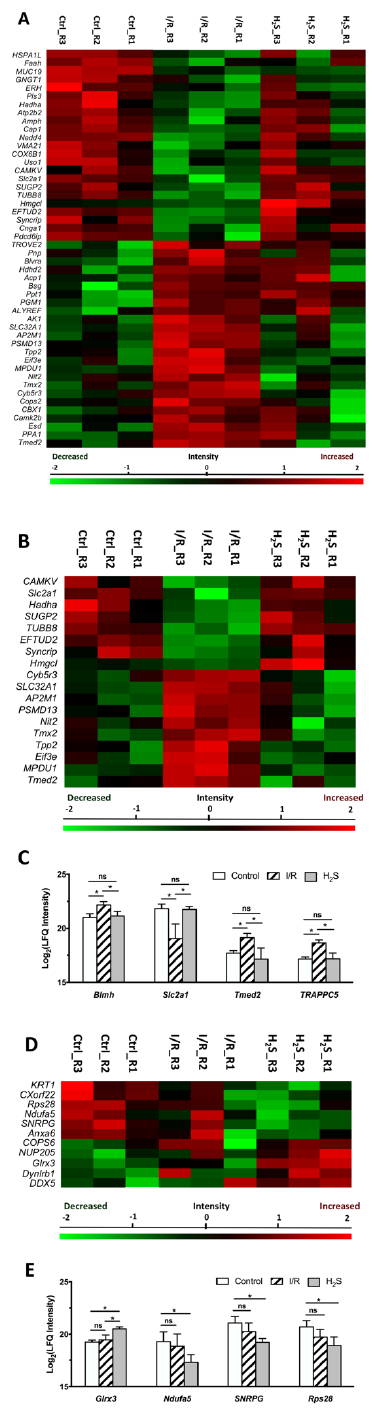
Figure 3. Differential expression profiles of retinal proteins in control, I/R and H 2 S. The relative protein abundance is represented as heat maps of each protein clusters. ( A ) A cluster of 48 proteins, the abundance of which were significantly altered due to I/R injury (also see Table 1); ( B ) a cluster of 18 proteins, the abundance of which were significantly altered due to I/R injury and restored by H 2 S (Table 2); ( D ) a cluster of 11 proteins, which were significantly differentially expressed in H 2 S group (Table 3). Charts showing the different expression profiles of ( C ) some of the significantly (* p < 0.05) dysregulated proteins in I/R group that were restored due to administration of H 2 S, ( E ) some of the significantly differentially expressed retinal proteins in H 2 S group.